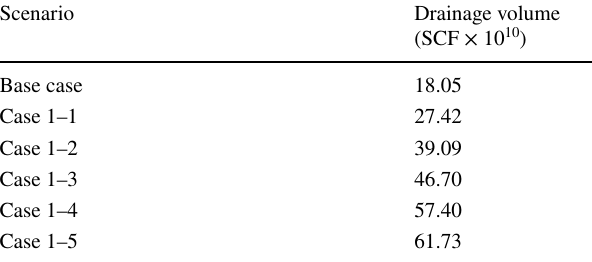
Table 13 DV from lateral length sensitivity Scenario